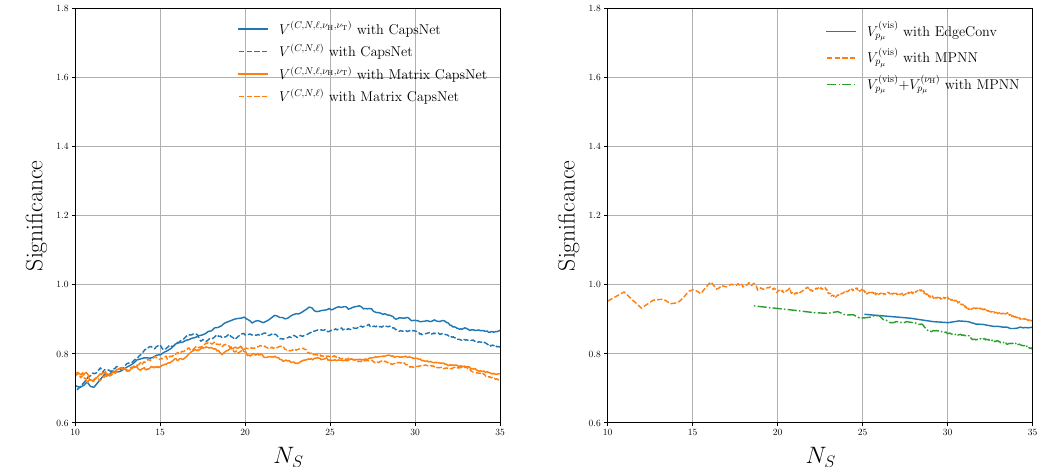
Figure 8 . Significance at the HL-LHC with L = 3 ab − 1 for CapsNets/Matrix CapsNets (left) and EdgeConv/MPNN